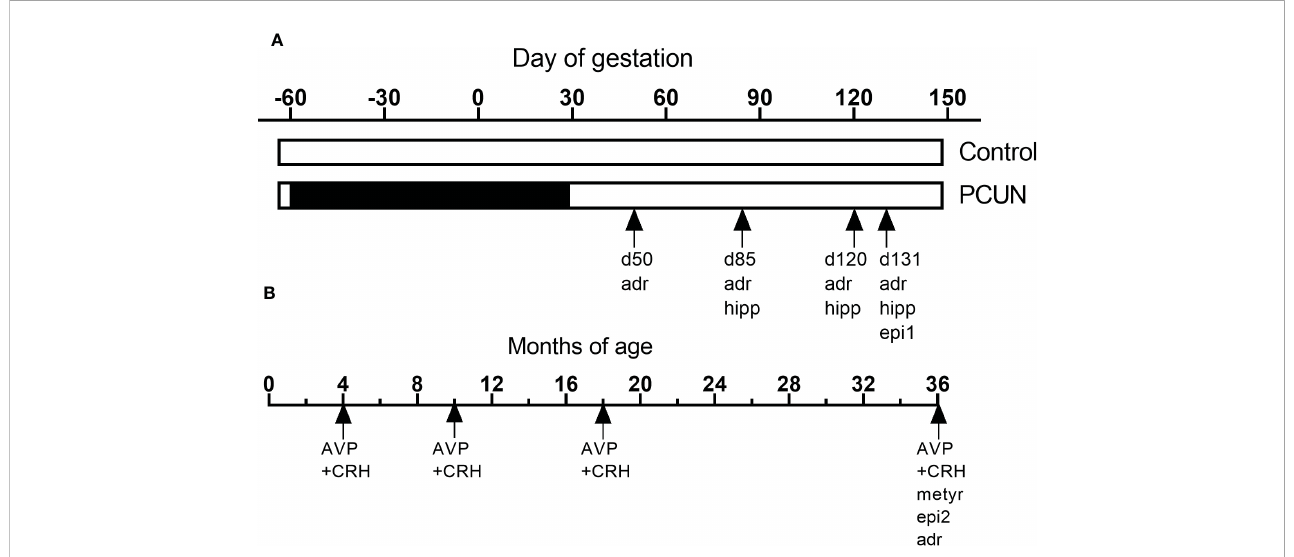
FIGURE 1 Schematic representation of the various studies using this cohort of animals during fetal (A) and postnatal life (B) . ‘ adr ’ , mRNA expression in adrenals. ‘ hip ’ , mRNA expression in hippocampus. ‘ epi1 ’ , fetal epigenetic studies (28). ‘ epi2, epigenetic studies in adult (29). ‘‘ AVP+CRH ’ , corticotropin stimulation tests in previous (13) and the current study. ‘ met ’ , metyrapone